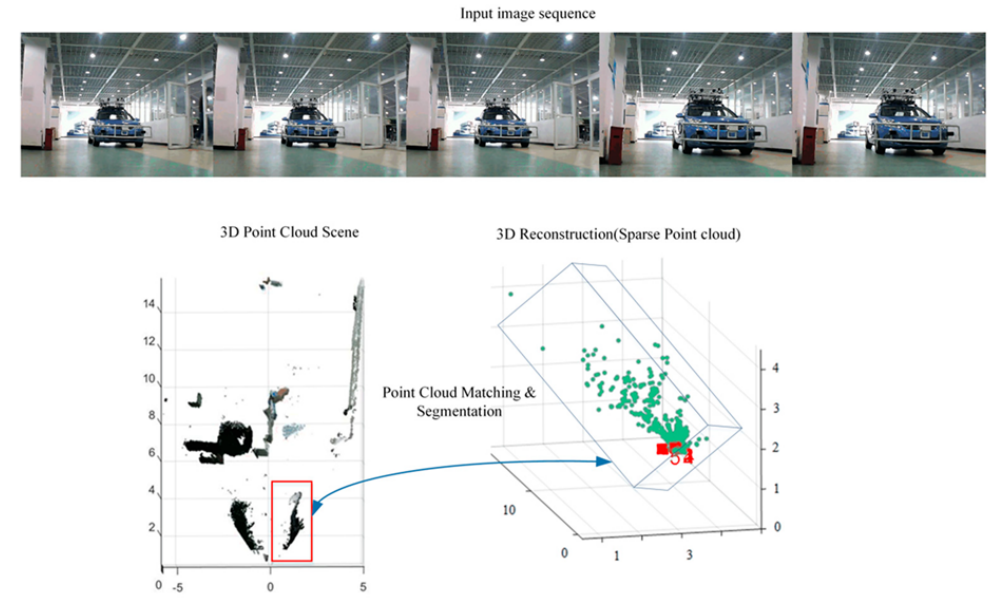
Figure 6. Point cloud matching and segmentation (image obtained from [14]).